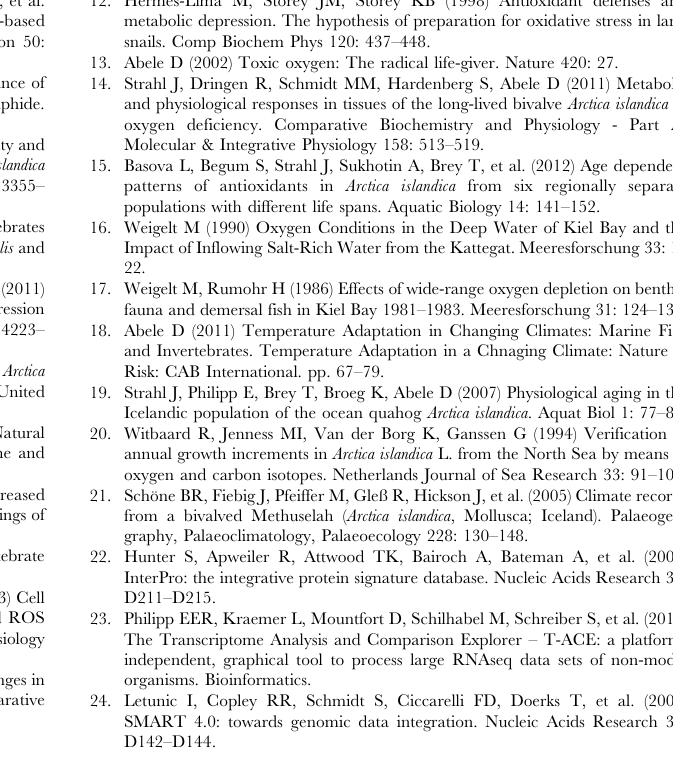
Table S1 Details of number and length of sequences generated by 454 technology and used for the transcrip- tome generation before and after cleaning. Table S2 Forward and reverse primer sequences used for semi-quantitative PCR and Sanger sequencing. (DOC) Table S3 General characteristics of candidate genes important for anoxia/hypoxia tolerance and general stress response identified in the A. islandica transcrip- tome. Given are the expected domains of the respective gene (deduced from homologene http://www.ncbi.nlm.nih.gov/sites/ entrez/query.fcgi?db =homologene) and observed domains in the contig (by SMART http://smart.embl-heidelberg.de/ and trans- membrane domains re-checked by THMM http://www.cbs.dtu. dk/services/TMHMM-2.0/), as well as length of the correspond- ing open-reading frame (ORF). Table S4 Contigs of A. islandica which show high similarity to candidate genes involved in the ageing process and immune system functioning. Given are the expected domains of the respective gene (deduced from homo- logene http://www.ncbi.nlm.nih.gov/sites/entrez/query. fcgi?db = homologene) and observed domains in the contig (by SMART http://smart.embl-heidelberg.de/ and transmembrane domains re-checked by THMM http://www.cbs.dtu.dk/services/ TMHMM-2.0/), as well as contig length, the read number the contig was assembled from and the longest open-reading frame (ORF). Further the best BLAST hit from the UniprotKB/ SwissProt and the NCBI nt database is given.